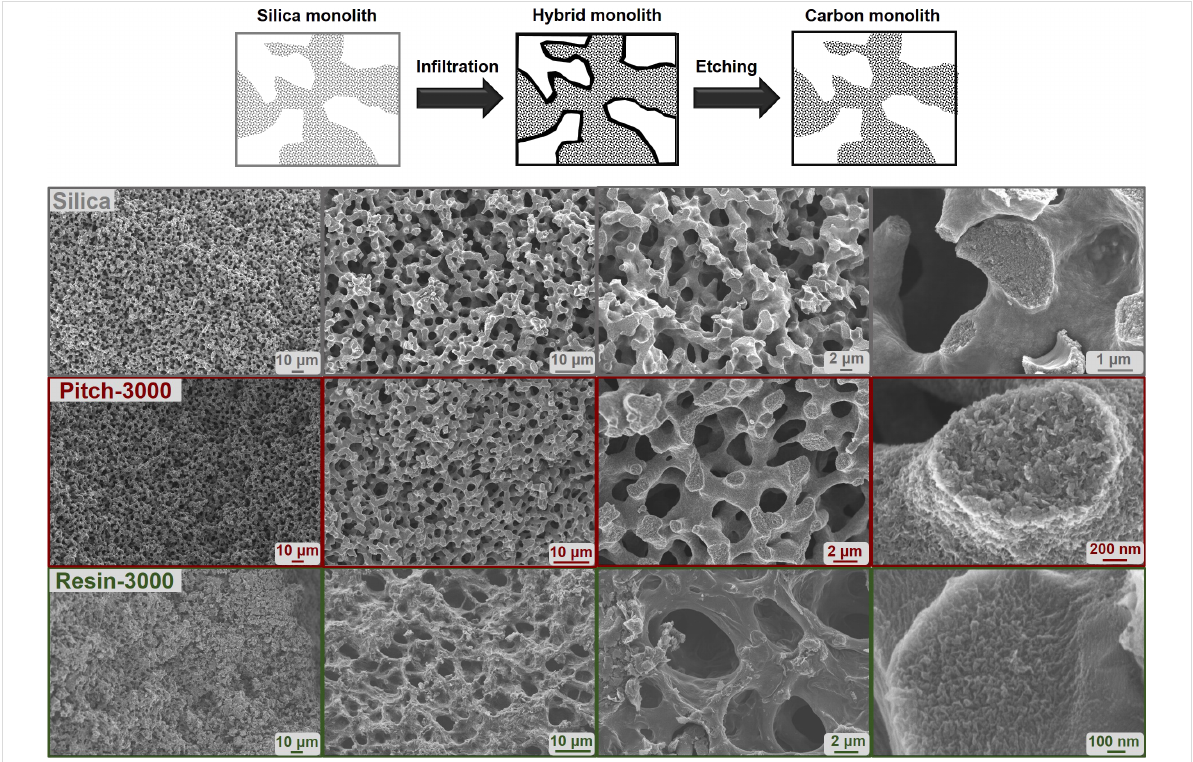
Figure 1: Scheme of the template process (top). SEM pictures of the silica template (grey), pitch-based (red) and resin-based (green) monoliths carbonized at 3000 °C.